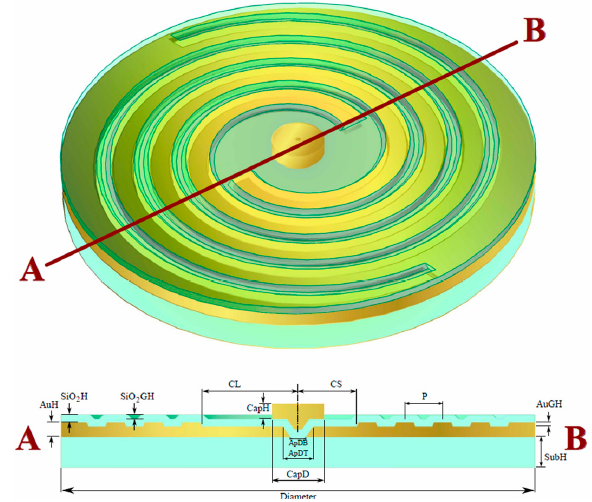
Figure 12. The perspective and cross-section view of ASG with the MIM waveguide. The dimensions of such a structure can be easily fabricated with state-of-the art photolithography systems. permission from [50]. Copyright Optical Society of America,